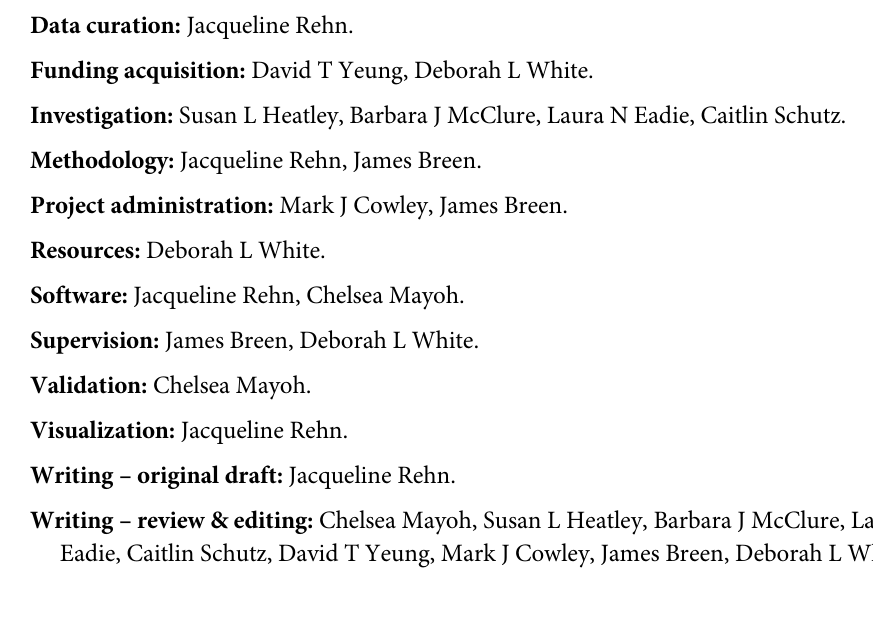
S4 Fig. Upset plot comparing detection rate of 164 clinically relevant gene fusions utilising both individual programs and combinations of RaScALL, FusionCatcher , arriba , JAFFA and SOAPfuse . (A) Intersection of reported driver gene fusions represented as a percentage of total driver gene fusions present in the cohort (n = 164). Each column corresponds to fusion calling algorithm (final 5 columns) or sets of fusion callers (dots connected by lines below the X axis). Only fusions reported by all fusion callers included in the set are considered. The per- centage of driver genes detected in each set appears above the column. (B) Union of reported driver gene fusions represented as a percentage of total driver fusions present in the cohort (n = 164). Fusions reported by any of the fusion callers included in the set are considered. The percentage of driver genes detected in each set appears above the column. (C) Graph of total number of driver gene fusions detected by each fusion calling algorithm.